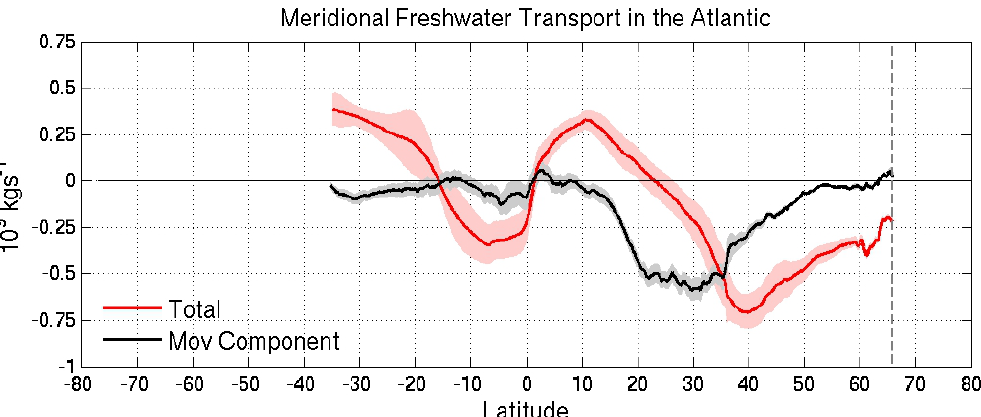
Fig. 10. The time mean meridional freshwater transport in the Atlantic at all latitudes, from UR025.3. The total meridional transport and the “MOV” component, due to the vertical overturning alone, are both shown. The shaded areas are the annual standard